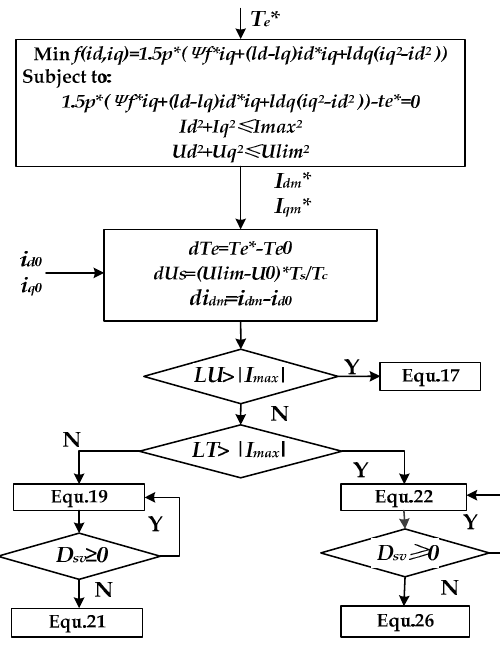
Figure 8. Schematic overview of the incremental current adjustment control.